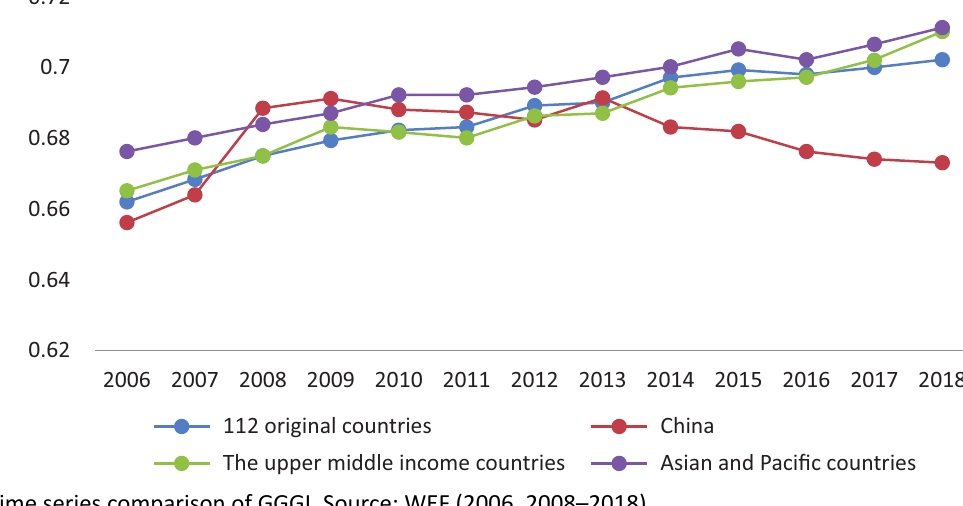
Figure 1. Time series comparison of GGGI. Source: WEF (2006, 2008–2018).